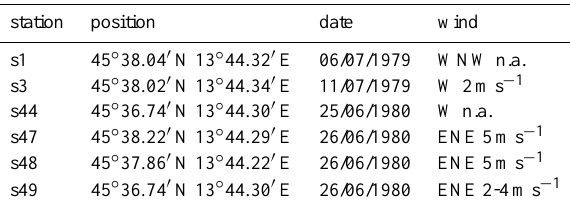
Table 3. Field measurements. Data from Stravisi (1990).